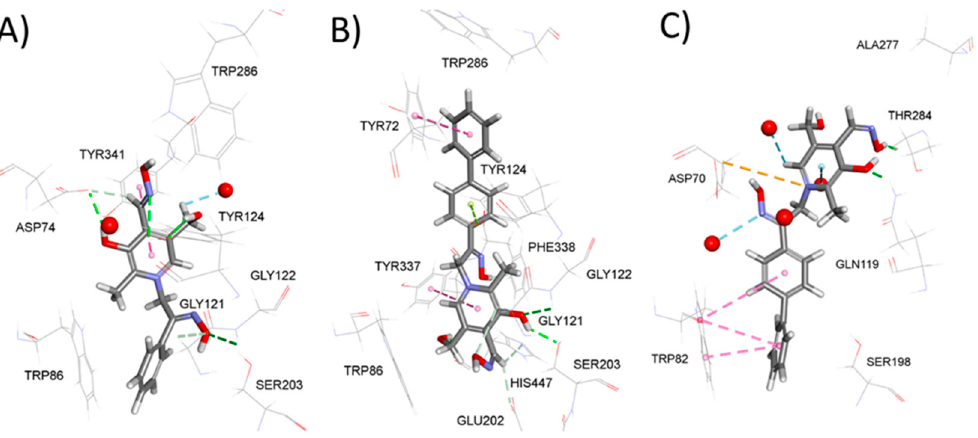
Figure 6. Close-up of the active site of the model complexes between AChE and compound 1 ( A ) or 7 ( B ) and BChE and compound 7 ( C ). Dashed lines represent different types of non-bonding interactions. Red spheres represent conserved water molecules. For clarity, only water molecules predicted to be engaged in non-bonding interactions are shown.